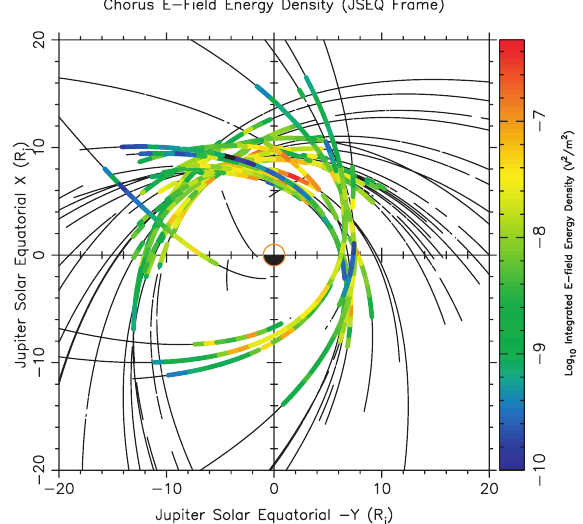
Fig. 4. The results of the complete survey in a plot of portions of the trajectory during which chorus emission was observed. The color code indicates the frequency-integrated power spectral density in units of (V/m) 2 . The plot is in solar equatorial coordinates with the sun in the +X direction and dawn in the +Y